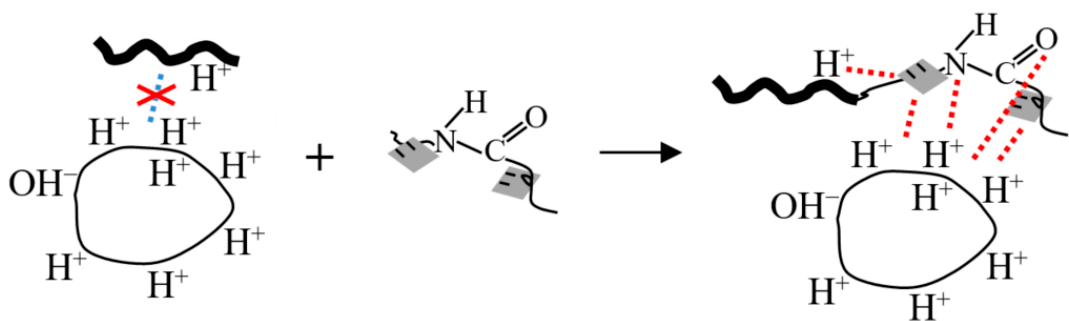
Figure 7. Schematic representation of interfacial adhesion mechanism between asphalt modified by OMMT/PAR and acidic aggregate. OMMT / PAR and acidic